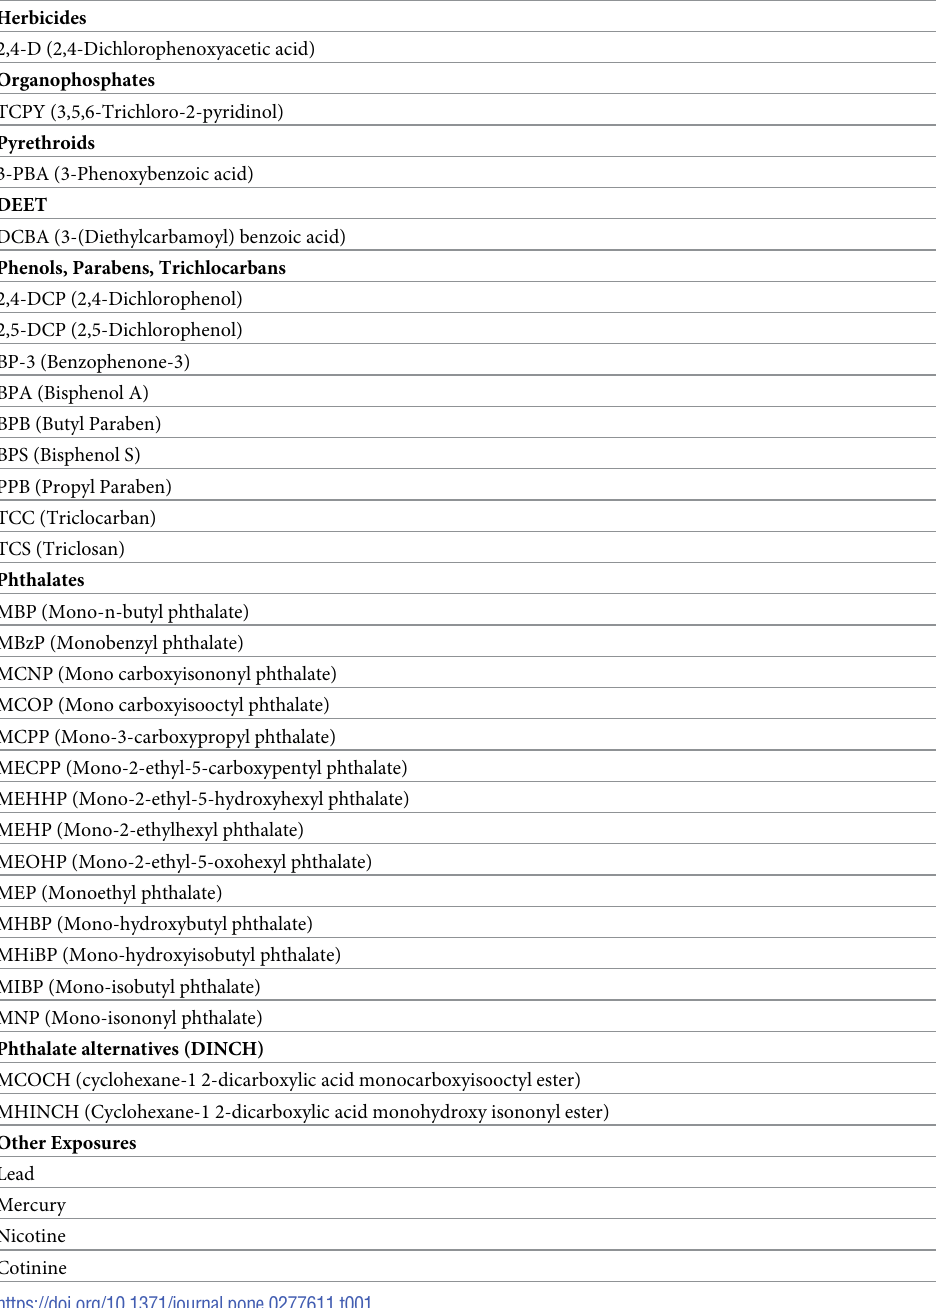
Table 1. Exposure biomarkers and chemical